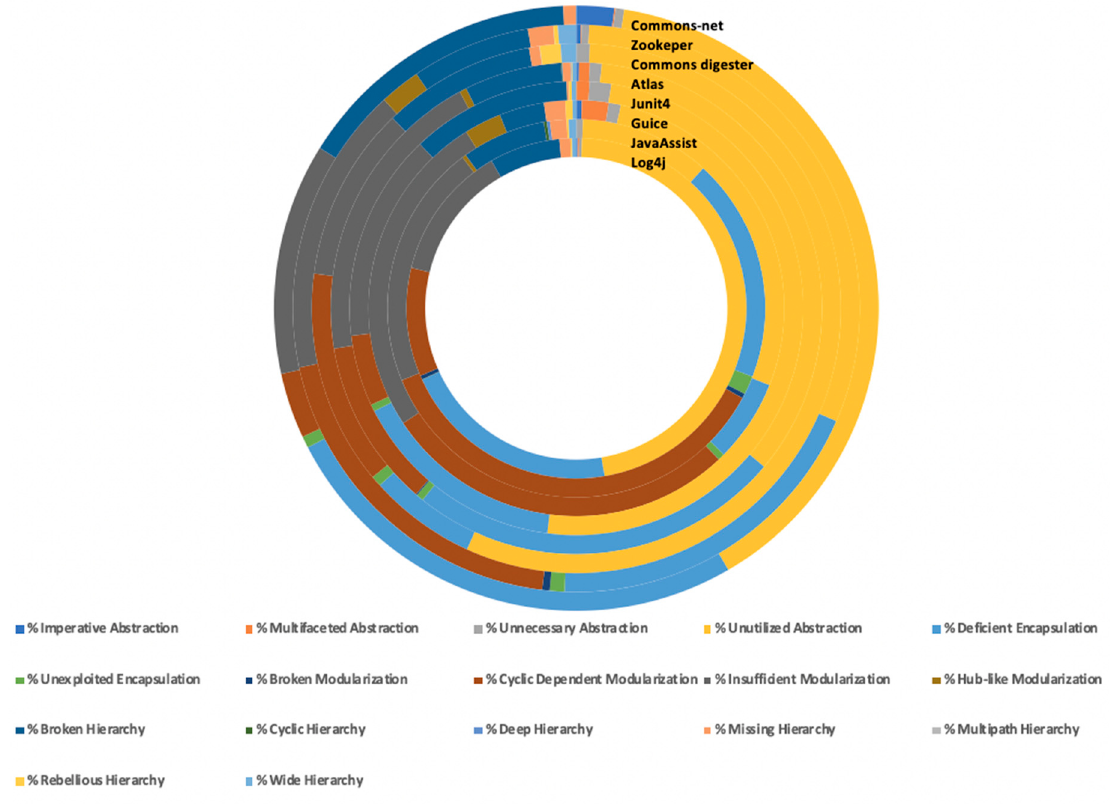
Figure 4. Percentage of changes on smelly files.